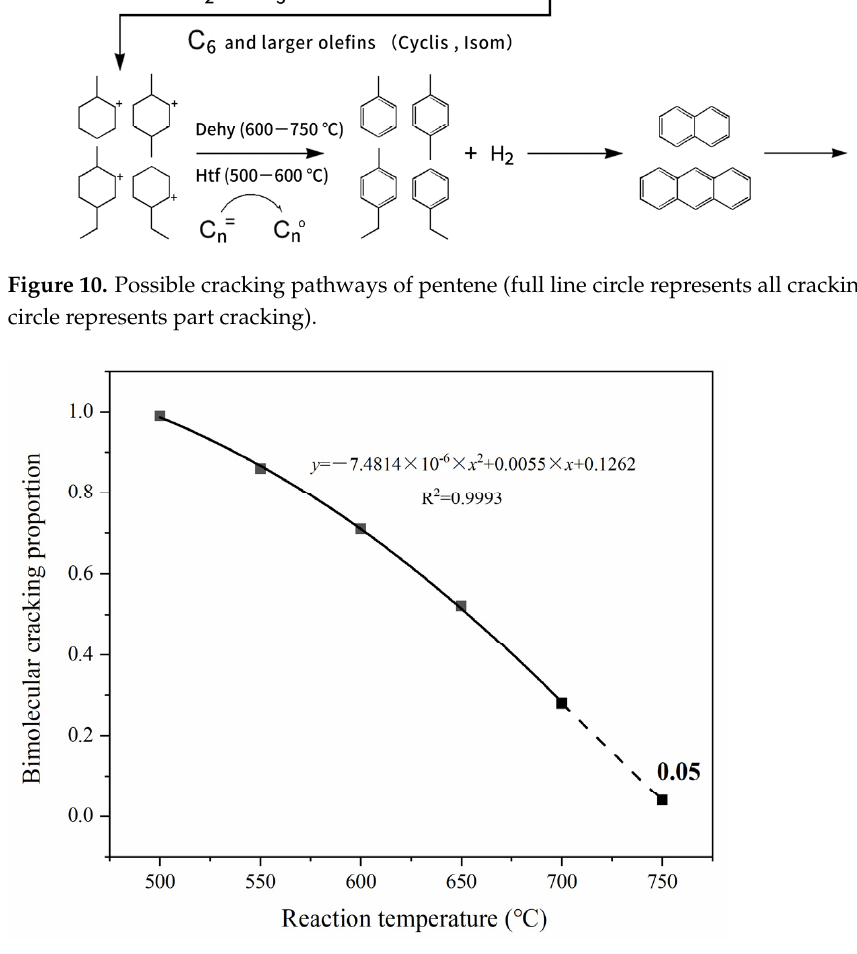
Figure 11. Bimolecular cracking proportions of pentene vs. reaction temperatures. Reaction condi- tions: total pressure, 130 kPa; partial pressure, 60 kPa; WHSV, 83 h − 1 .